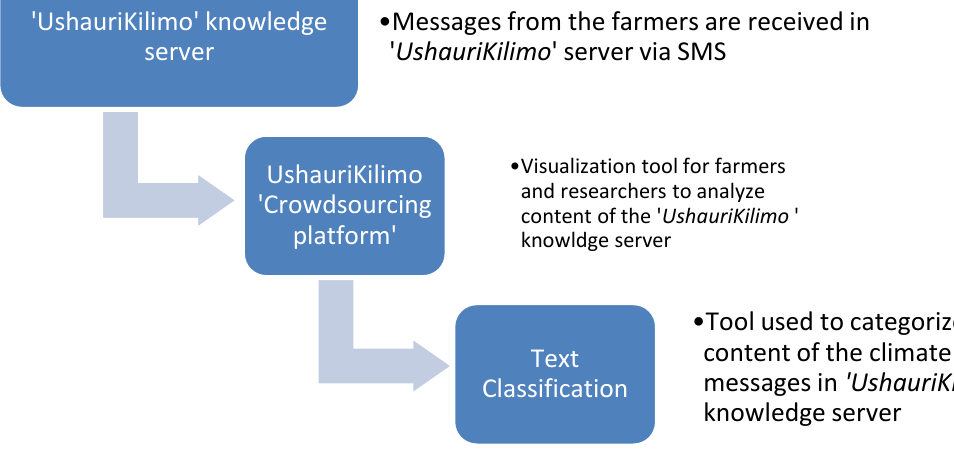
Figure 1. Data analysis